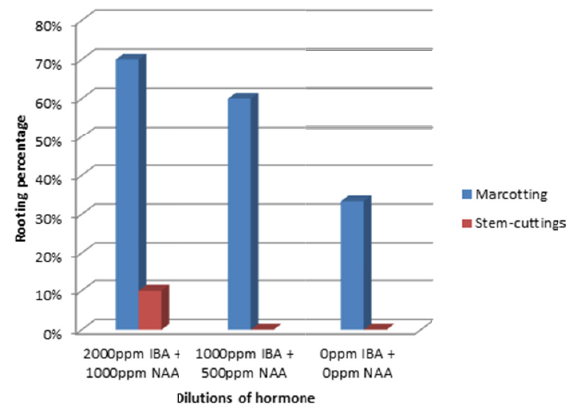
Fig. 1. Rooting percentage of different dilutions of hormone on akee marcotting and stem-cuttings